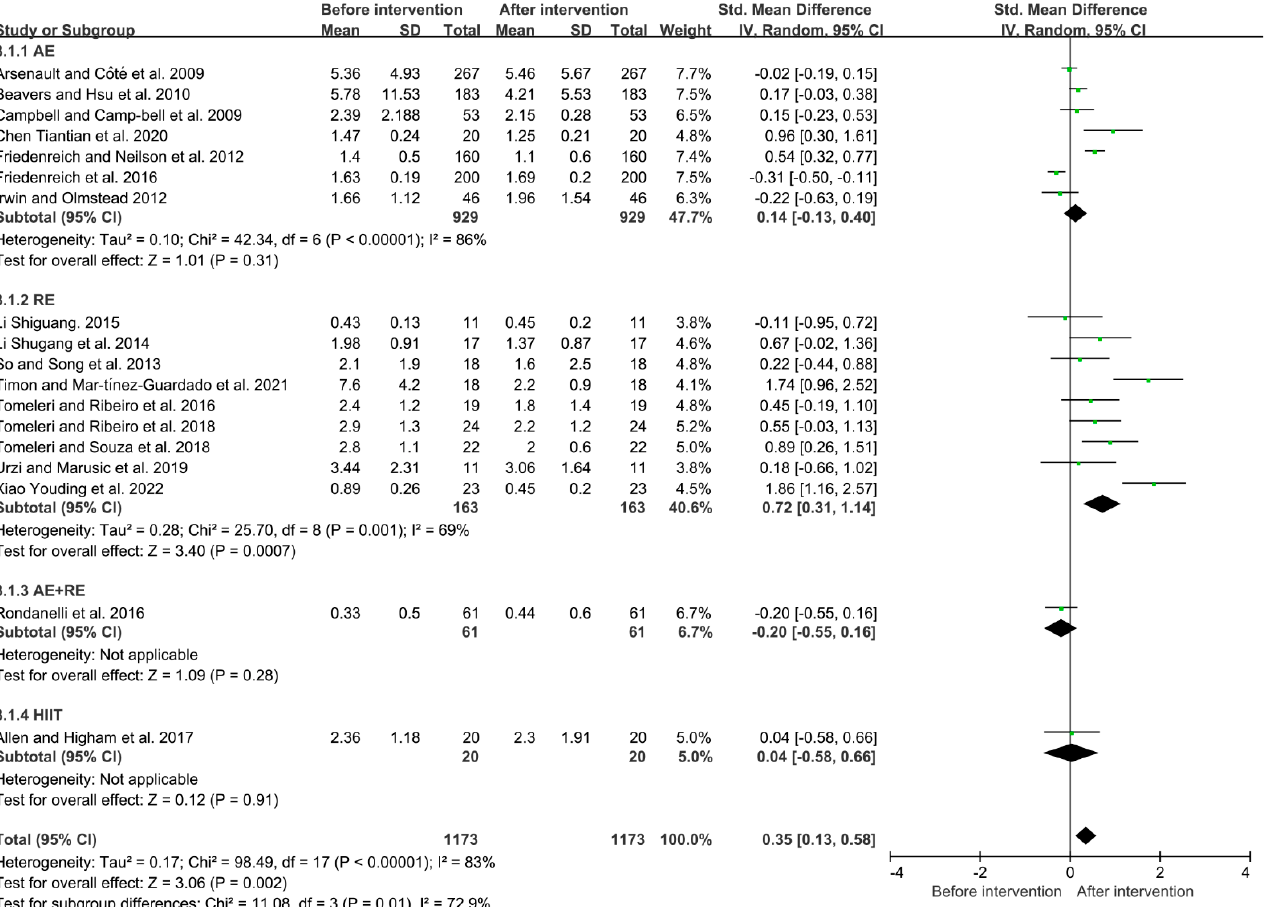
Table 3. Subgroup analysis of the effect of different modes on inflammatory response in the elderly.